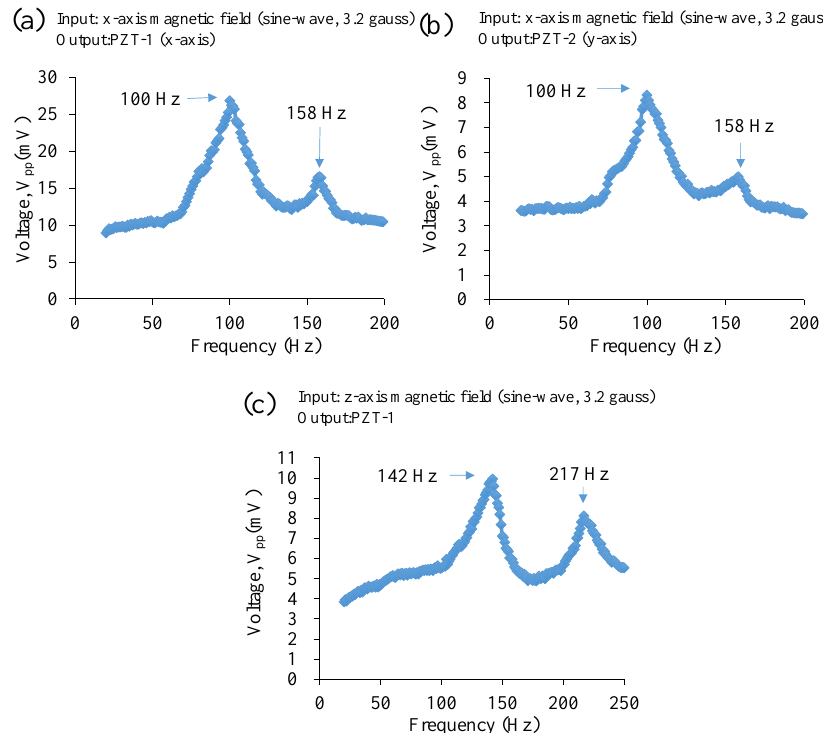
Figure 6. Experimental results of the measurement of the magnetic-field-induced resonant frequency: The voltage output vs. magnetic-field-frequency plots of the AC magnetic sensor under: ( a , b ) x -axis magnetic field ( sine-wave, 3.2 gauss), and ( c ) z -axis magnetic field ( sine-wave, 3.2 gauss). After the resonant frequencies of the sensor were obtained, and we applied the x -axis and z -axis magnetic fields with different magnitudes at the sensor’s resonant frequency to the sensor, respectively. The voltage outputs versus magnetic-field magnitudes are plotted and correlated by curve fitting, as shown in Figure 7. In Figure 7, the voltage outputs have a good linearity with the magnetic-field magnitudes. The voltage outputs with the sensitivities of the PZT-1, PZT-2, PZT-3, and PZT-4 of the sensor under the x -axis magnetic field (sine-wave, 100 Hz, 0.2–3.2 gauss) are 1.13– 26.15 mV with 8.79 mV/gauss, 0.43–8.21 mV with 2.66 mV/gauss, 1.33–27.43 mV with 8.48 mV/gauss,